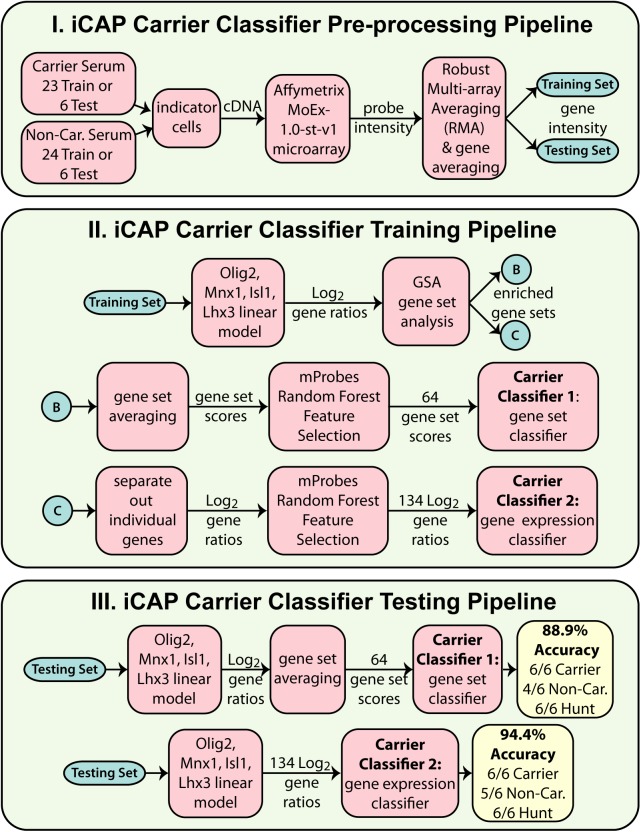
Classifier pipelines.I. 47 training samples or 12 test samples passed through the pre-processing pipeline, which resulted in normalized gene intensity scores. II. The classifiers were trained. 12 non-carrier (non-car.) samples in the 47 training examples were used to construct a linear model of gene expression based on control genes, which was used to convert all gene intensities into log2 gene expression ratios. These ratios were used to identify differentially expressed gene sets and ultimately select 64 gene sets or 134 genes that could differentiate between non-carrier and pre-symptomatic carrier mice using SVMs. III. The classifiers were tested. Gene intensities from 12 pre-processed but de-identified examples were converted to expression ratios using the linear model trained in II, and data sets composed of the 64 gene sets or 134 genes identified in II were extracted. The de-identified examples described by these data sets were classified as carrier or non-carrier using the SVMs trained in II. The pipeline for Classifier 3 was identical to that of Classifier 1 except that a different GSA score threshold was used (|GSA| ≥ 1 instead of GSA ≤ -1), resulting in selection of 106 gene sets instead of 64. For classifier testing with Huntington’s samples, classifiers were trained with all 59 normal and disease samples (not shown) and tested against 6 Huntington’s samples. For each classifier configuration, the fraction of Huntington’s samples that were correctly predicted as non-carriers of the ALS mutation is shown as ‘Hunt’ tally.